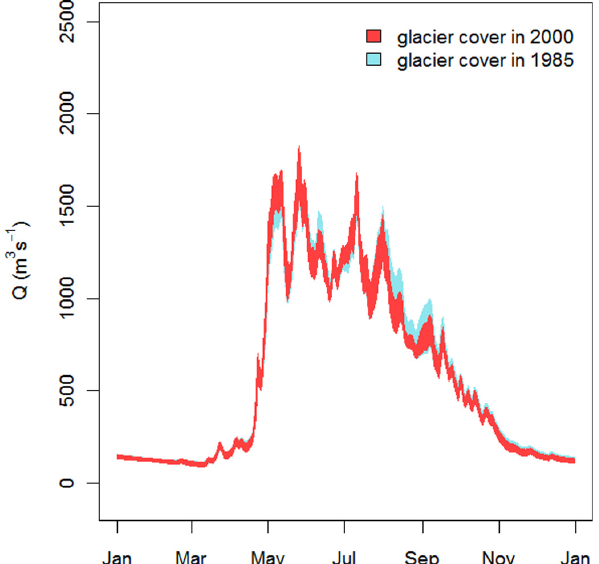
Fig. 10. Illustration of the sensitivity of simulated streamflow to glacier changes during the calibration period, based on a compar- ison of ensemble simulations for the year 1998 using the glacier coverages from 1985 and 2000.